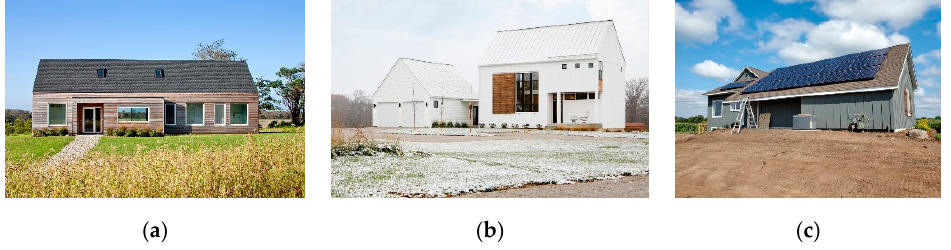
Figure 3. Examples of rural houses with low energy consumption in cold regions in the USA: ( a ) New England house [15], ( b ) Indianapolis house [16], ( c ) Afton house [17].